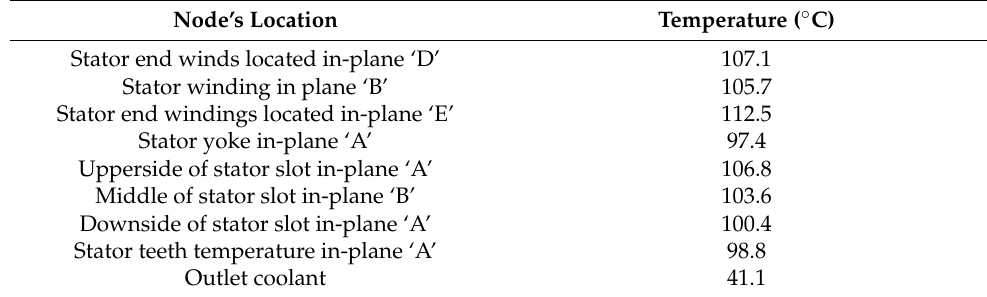
Table 3. Analytical results of the thermal model.